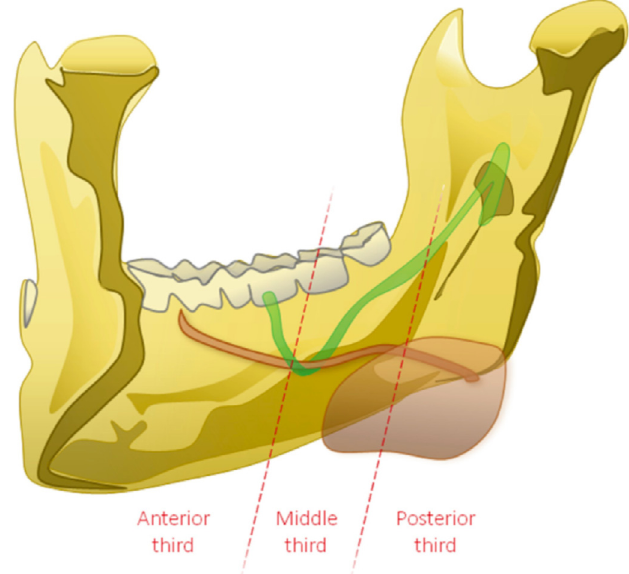
Fig. 2. The submandibular duct (or Wharton ’ s duct) constitutes the submandibular gland ’ s excretory duct and is usually divided into thirds (an anterior, a middle and a posterior